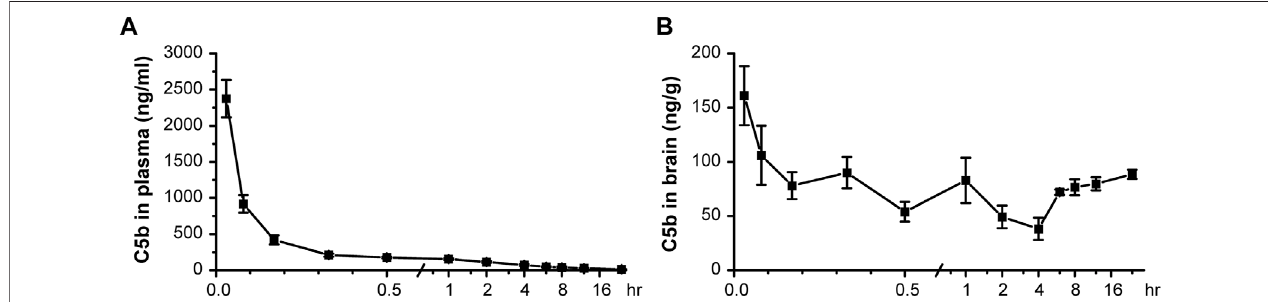
FIGURE3| Pharmacokinetictest invivo indicatedthatC5bisBBBpermeable. (A) C5b(5 mg/kgdissolvedinsaline)wasinjectedintomicethroughthecaudalvein. TheplasmaconcentrationsofC5batdifferenttimesaftertheintravenousadministrationwereaccessedfromwholebloodanddetectedbyHPLC-MS/MS. n =5foreach point. (B) WholebrainsweredissectedatdifferenttimesaftertheintravenousadministrationandhomogenizedfordetectionoftheC5bconcentrationbyHPLC-MS/MS. n = 5 for each point. Concentrations were calculated based on the standard curve prepared in advance. Data are mean ±